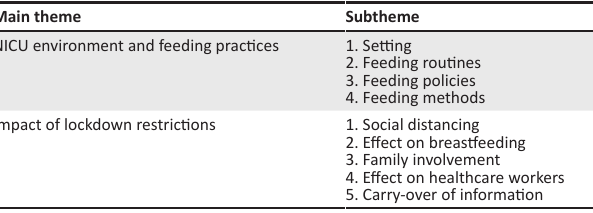
TABLE 3: Themes and